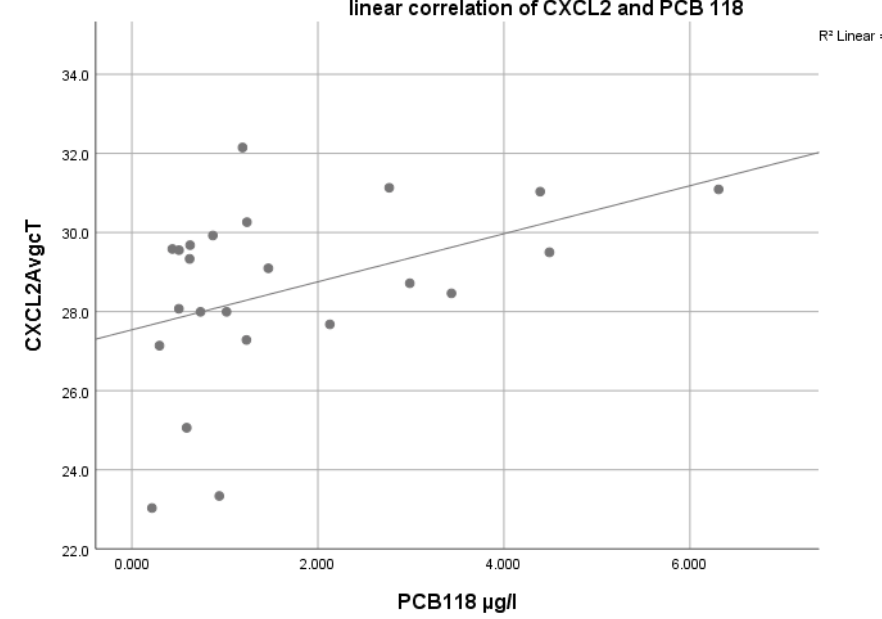
Figure 1. Plasma levels of PCB 118 (in ng/g lipids) and the regulation in CXCL2. For IL-6 we found a significant correlation with the sum of the dl-PCB congeners ( p : 0.032, ρ : 0.478), and PCB 118 ( p : 0.044, ρ : 0.502). For HCB and DDE no significant correlation with MMP-9, CCL7, CCL20, CXCL2, IL-1 β or IL-6 was found (data not